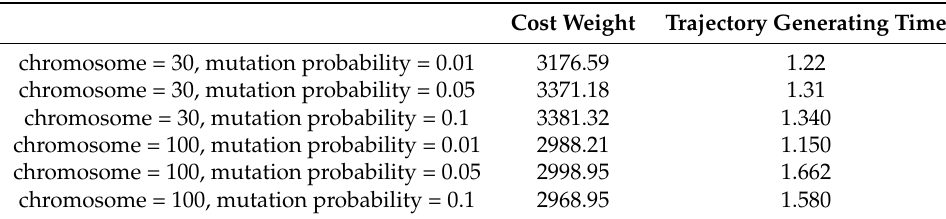
Table 8. Comparison results of parameters setting for